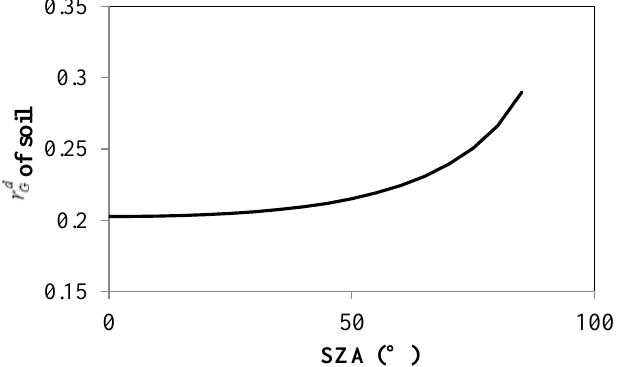
Figure 9. Variation of the directional-hemispherical reflectance d zenith angle